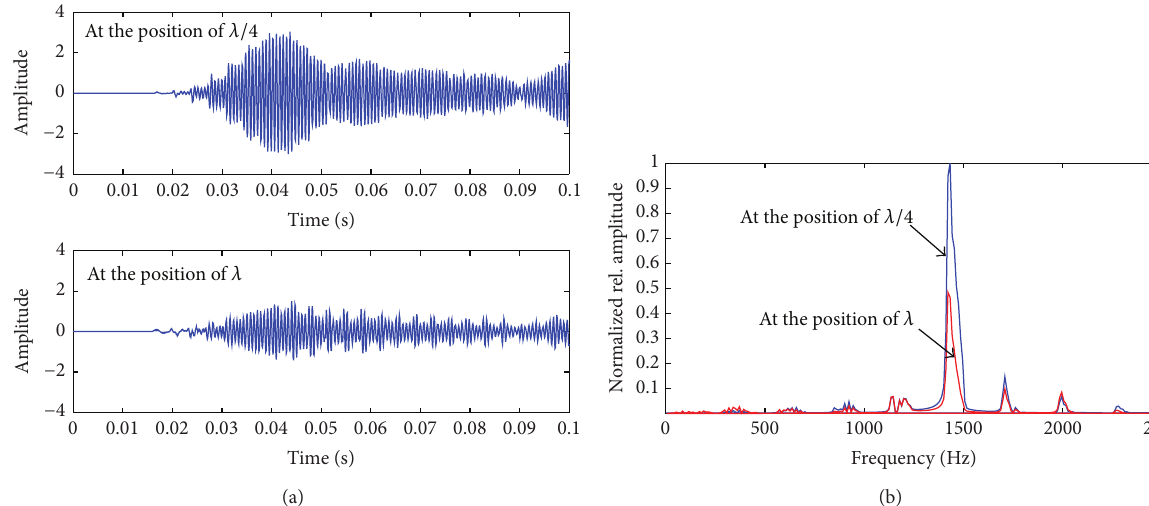
Figure 1: Simulation results of received signals at different receiving positions. (a) Time-domain signal, (b) frequency-domain signal.